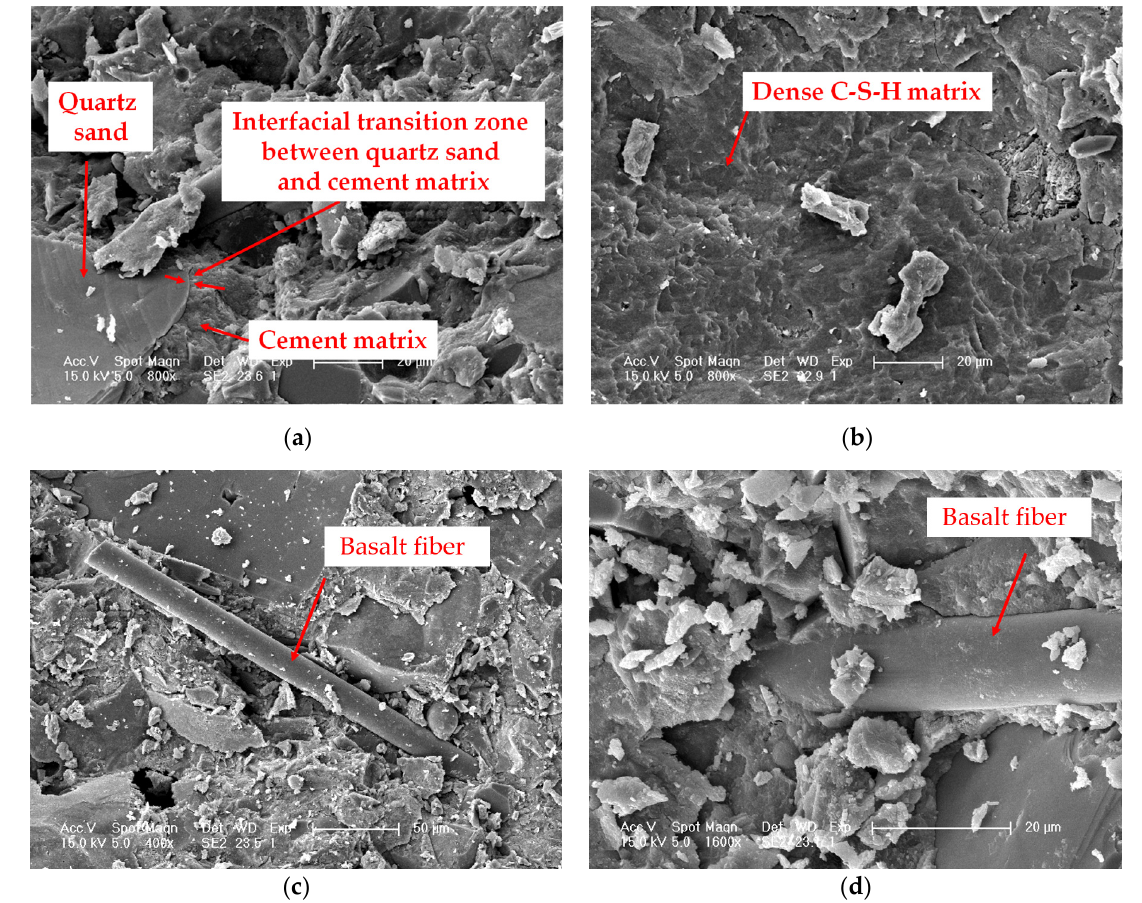
Figure 8. Microstructure of basalt fiber polymer-modified RPC: ( a ) Interfacial transition zone between quartz sand and cement matrix; ( b ) Dense C–S–H matrix; ( c ) Basalt fiber 400x; ( d ) Basalt fiber 1600x.